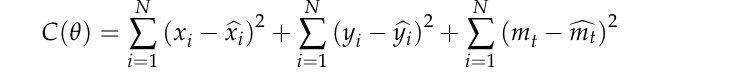
Table 5. The output state variables for simulation under certain operating conditions were used as the output variables. In order to evaluate the accuracy of parameter identification, the parameter error (PE) and average parameter error (APE) were used to measure the accuracy of the model parameters. The calculation formulas of PE and APE are as